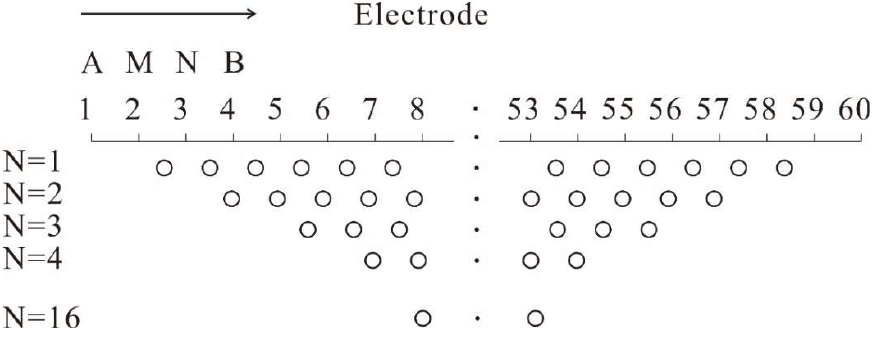
Figure 2. α array for multi-electrode, locations attributed to apparent resistivity measurements.